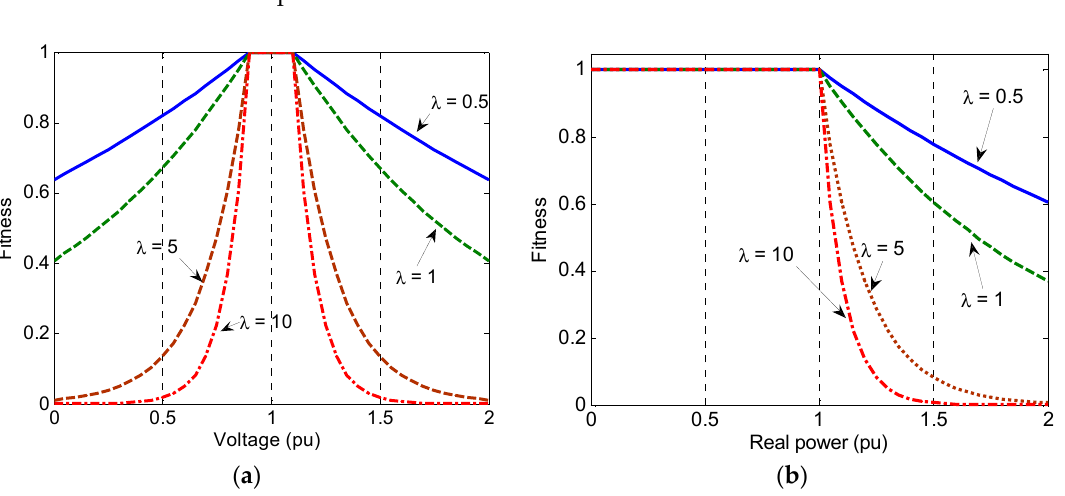
Figure 5. Sub-functions for: ( a ) voltages in load buses and ( b ) power flows in lines, for different lambdas.